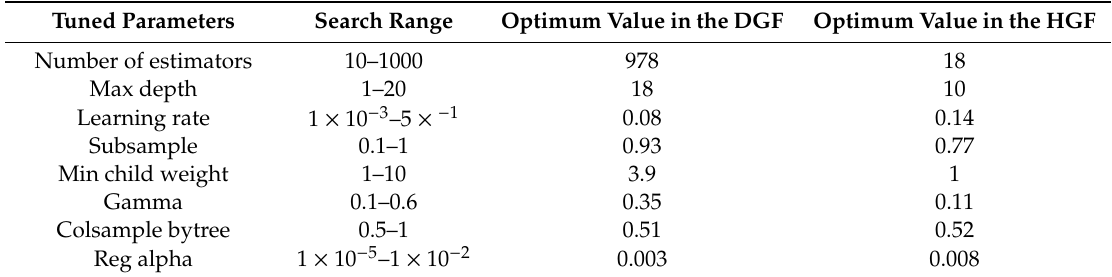
Table 2. Tuned parameters for XGBoost and tuned optimum parameter value in the DFG and